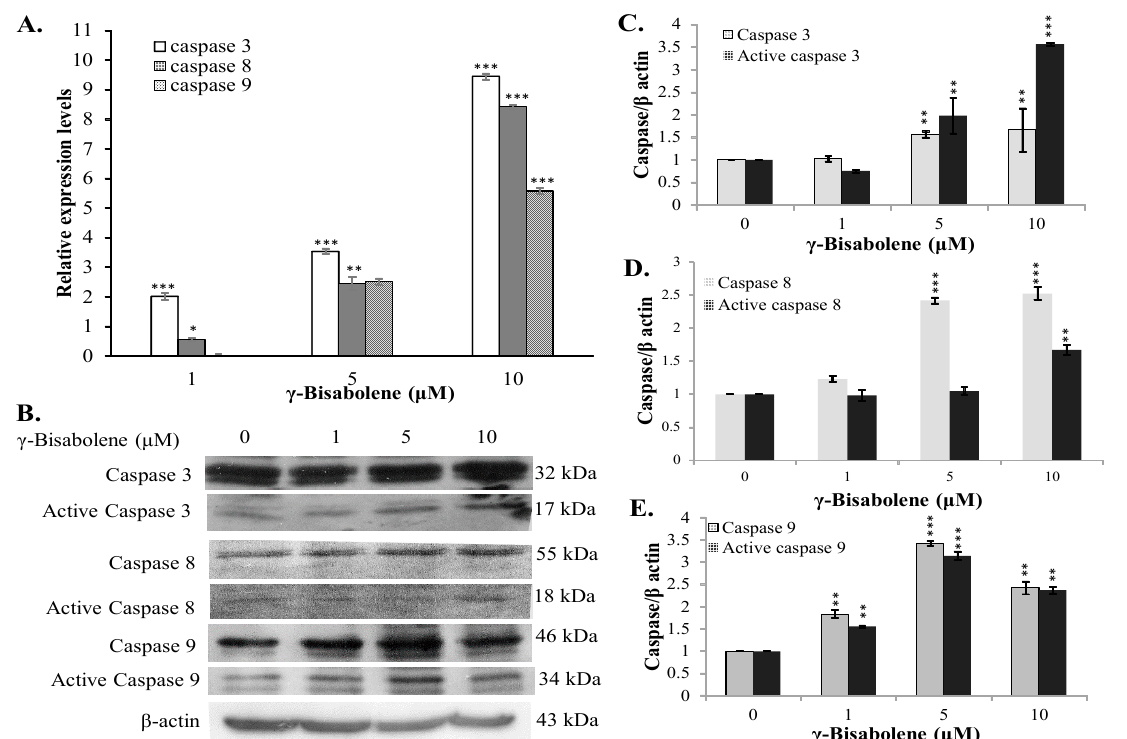
Figure 3. Relative mRNA and protein levels of caspases-3, 8, and 9 in γ -bisabolene-treated cells. Cells were harvested for total RNA extraction and western blotting 48 h post treatment. The relative gene expression was normalized to GAPDH in real-time PCR assays ( A ); Active forms of caspases 3, 8 and 9 in TE671 were characterized using western blotting ( B ); Relative band intensity of indicated caspase or active caspase was normalized by β actin, compared to the mock cells, and quantified using imageJ based on triplicate replicates of each experiment ( C – E ). **, p value < 0.01; ***, p value < 0.001 compared with untreated cells.